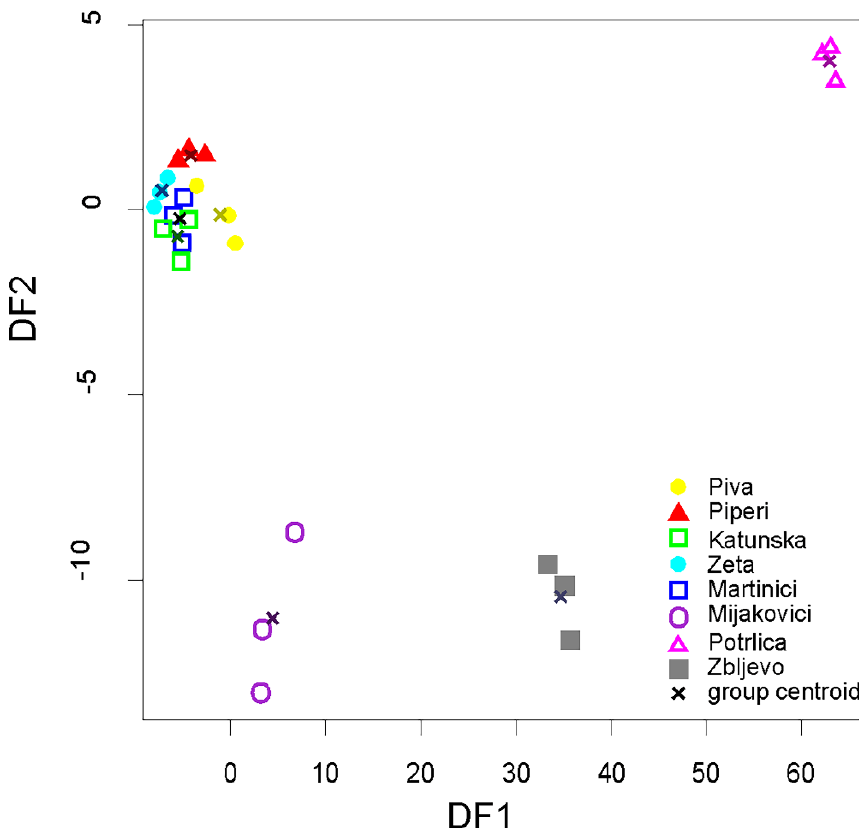
Figure 3. Linear discriminant score plot of analyzed honey samples.